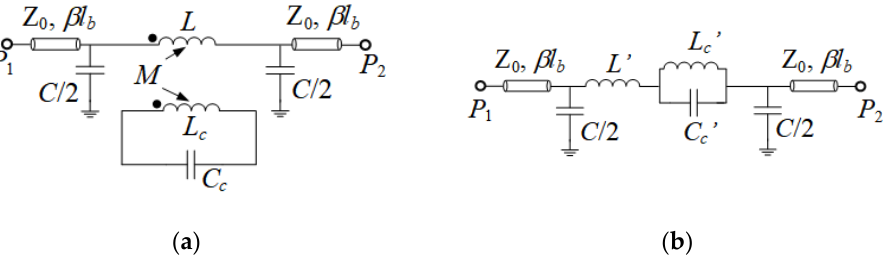
Figure 2. Circuit model of the DB-DGS-loaded microstrip line with the resonator magnetically coupled to the line ( a ) and transformed model ( b ).